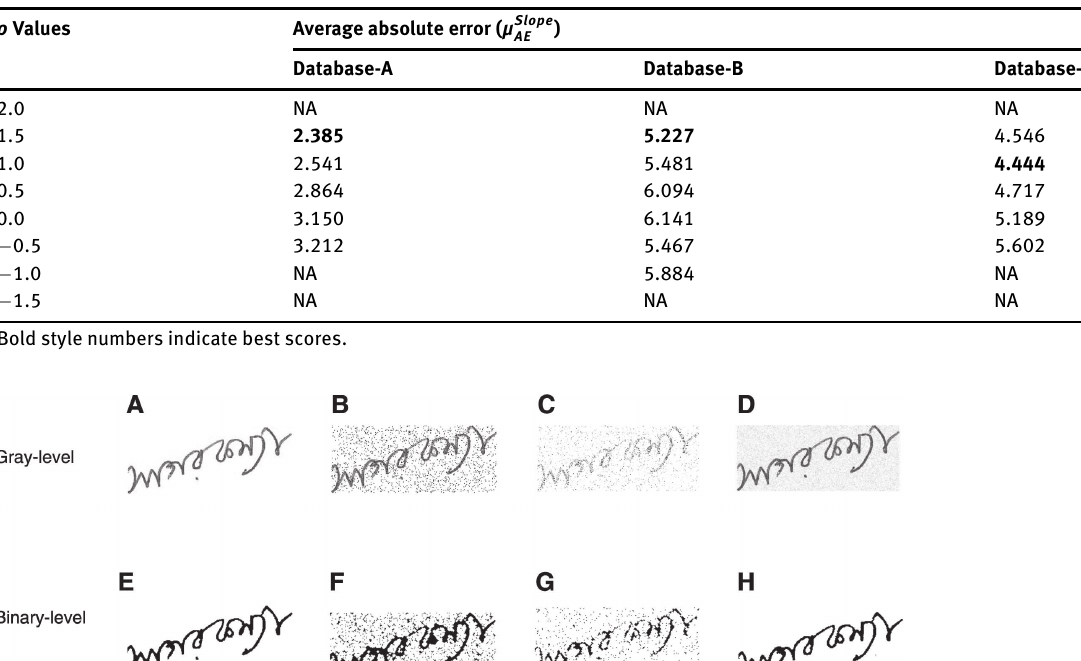
Table 1: Average Error Recorded for Varying Values of ρ .